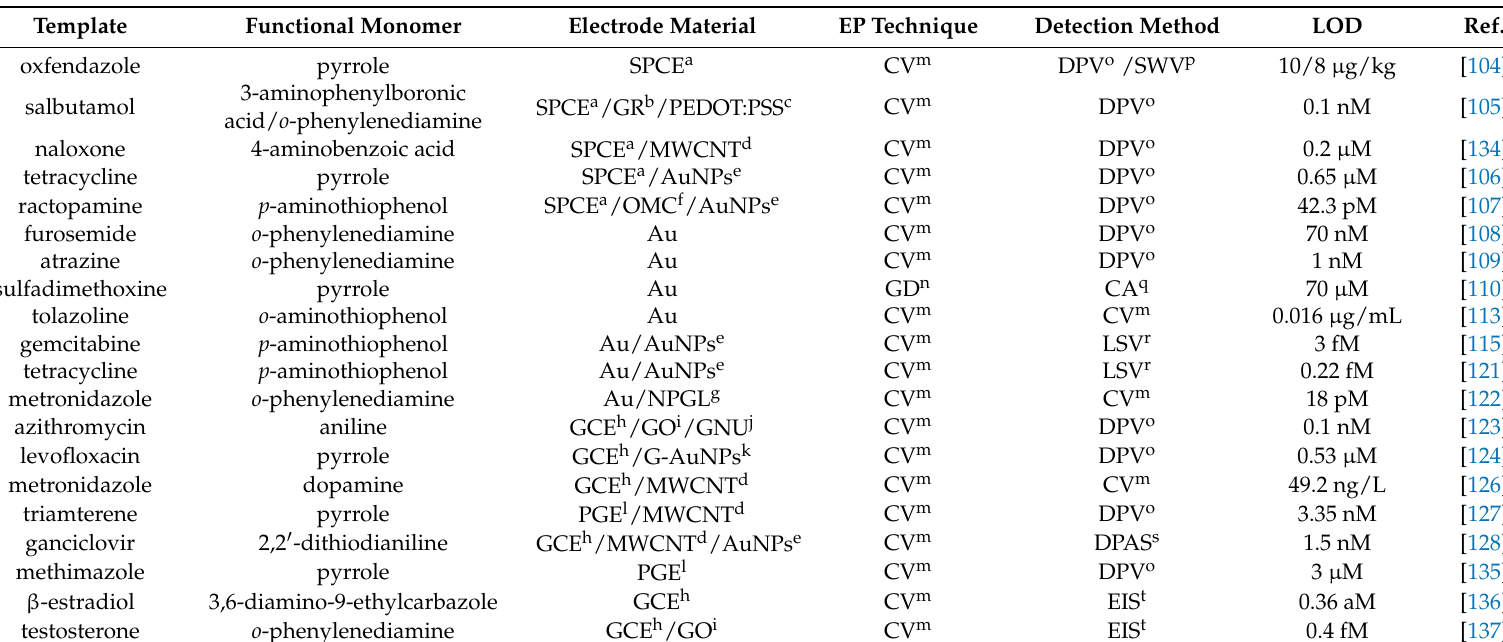
Table 3. Summary of recent publications for the detection of drugs using eMIPs. Includes information on the functional monomer used, electrode material, polymerization technique, detection method, and